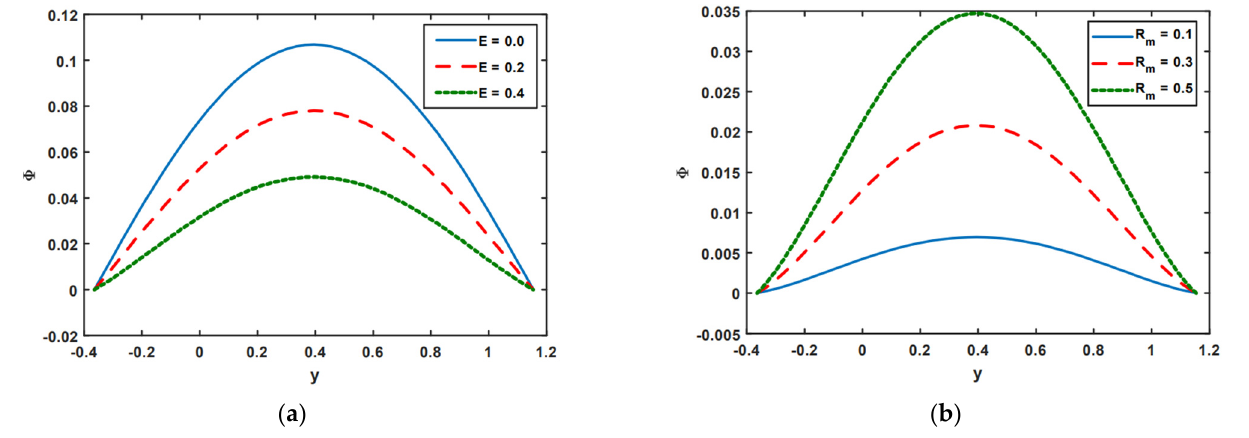
Figure 7. (a, b) Impact of 𝐸 and 𝑅 (cid:3040) on magnetic force function 𝛷 . Figure 7. ( a , b ) Impact of E and R m on magnetic force function Φ .